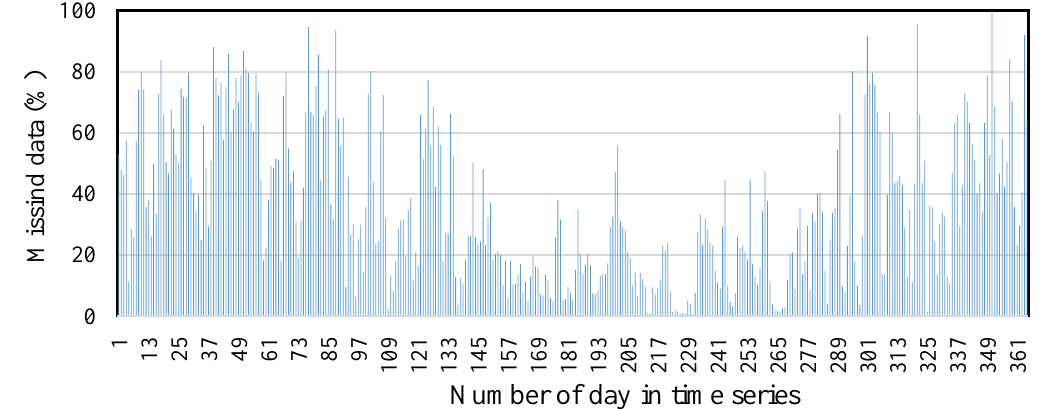
Figure 4. The missing data percentage of each image (temporal dispersion) in the annual LST time series during the night.